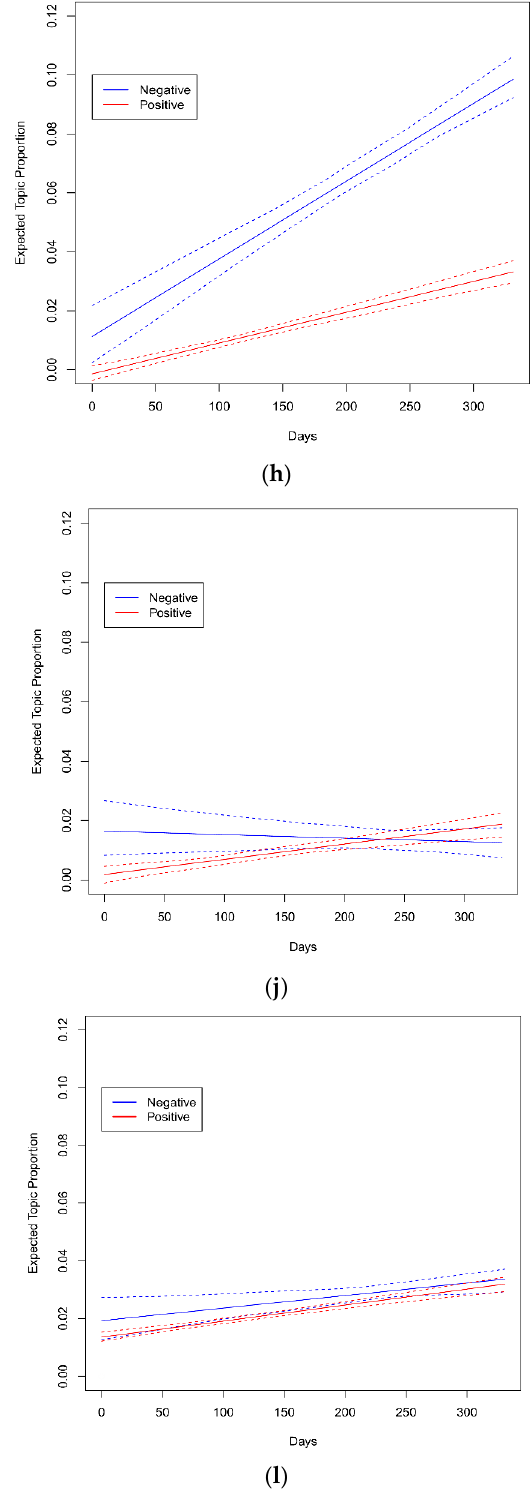
Figure 5. Change in topic prevalence based on sentiment polarity over time. ( a ) Information seeking (topic 1); ( b ) advice and sharing (topic 2); ( c ) media promotion (topic 3); ( d ) celebrity effect (topic 4); ( e ) community effect (topic 5); ( f ) encouragement (topic 10); ( g ) World Mental Health Day (topic 11); ( h ) public stigma (topic 6); ( i ) self-stigma (topic 7); ( j ) mental health service (topic 8); ( k ) patient stories (topic 9); ( l ) symptoms description (topic